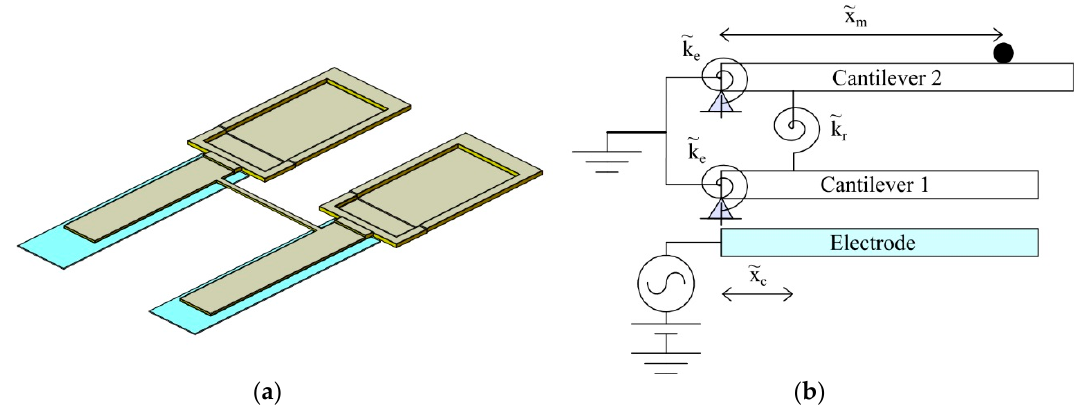
Figure 1. ( a ) Coupled MEMS cantilevers for mass sensing; ( b ) model of two coupled beams with added point mass and electrostatic